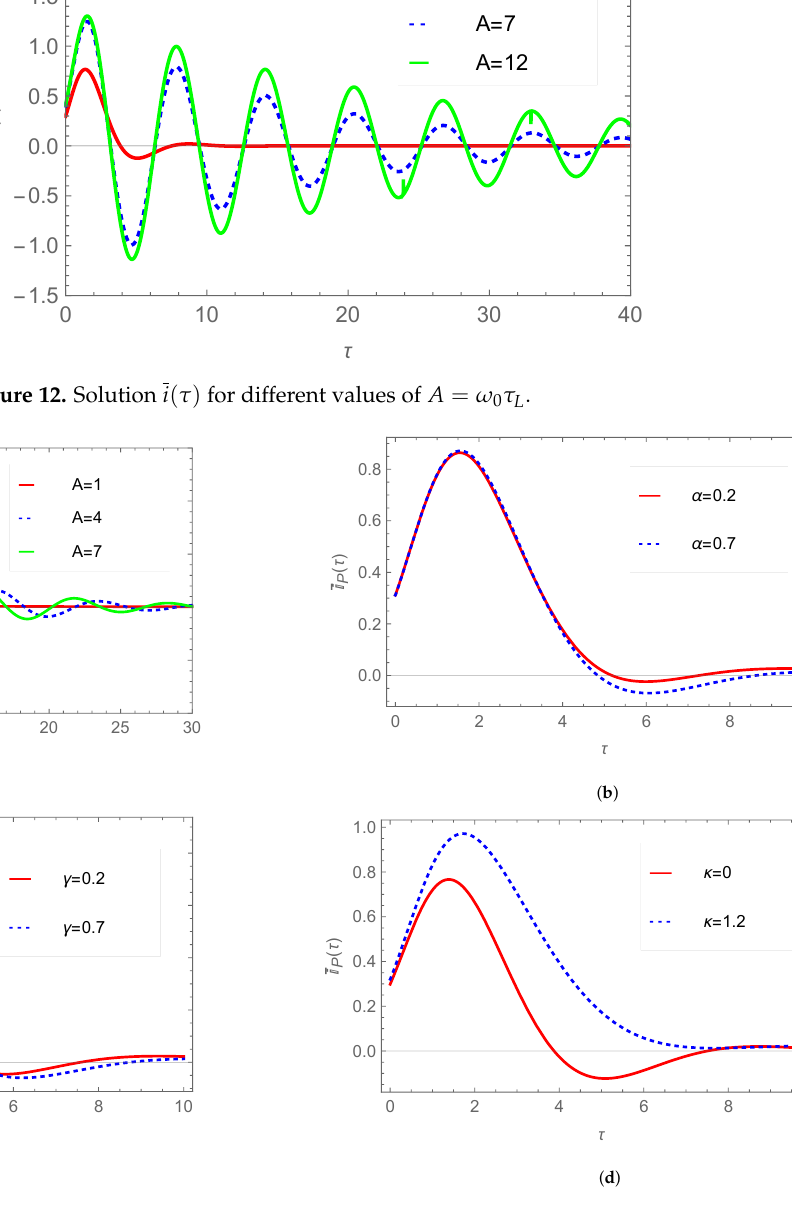
Figure 13. Solution i P ( τ ) for different values of A , α , γ , κ . ( a ) Different values of A = ω 0 τ L with α = 0.2, γ = κ = 0.5; ( b ) Different values of α with A = 1, γ = κ = 0.5; ( c ) Different values of γ with A = 1 and α = κ = 0.5; ( d ) Different values of κ with A = 1 and α = γ =